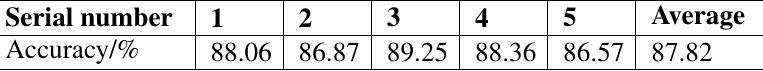
Table 3 Diagnosis results based on the colour moment feature quantity